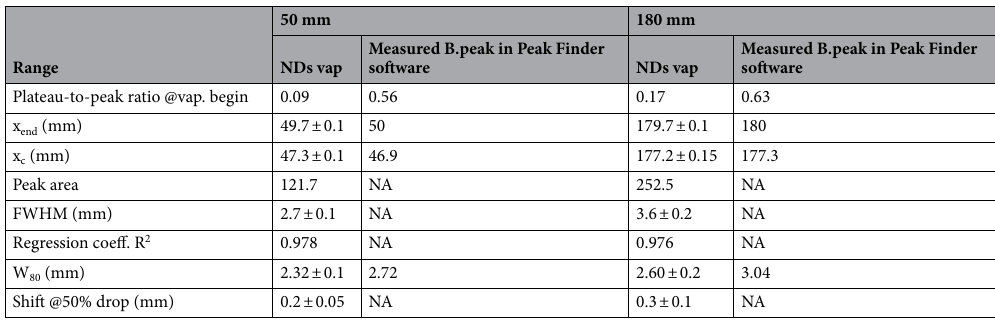
Table 2. Analyses of the NDs vaporization profiles (1 Gy, 4 × 10 6 NDs/ml) vs. the measured Bragg peaks at 50 mm and 180 mm beam ranges. The results derive from a Gaussian fit function of the grayscale